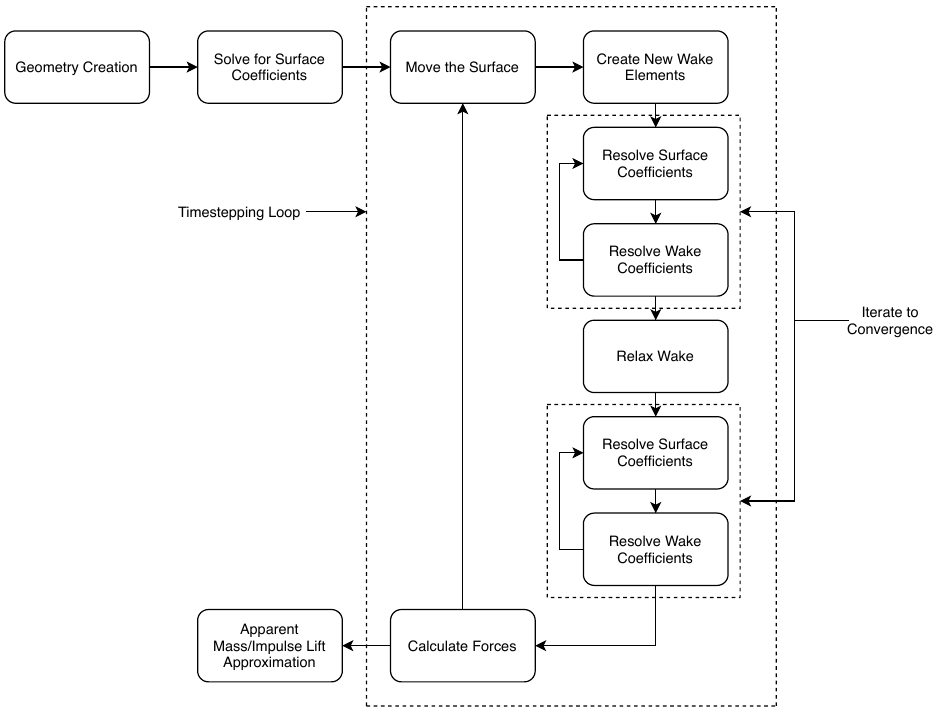
Figure 5. An overview of the DDE